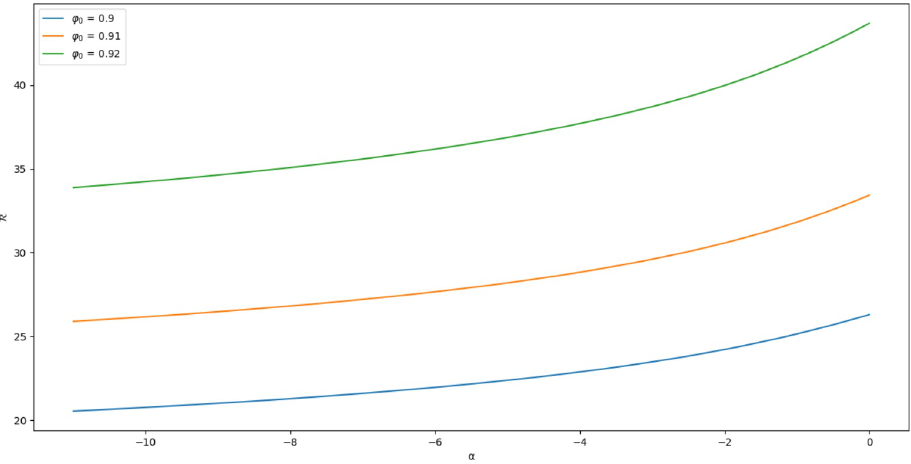
Figure 7 . The dimensionless curvature R as a function of α for fixed values of ϕ 0 , for Nut end- point